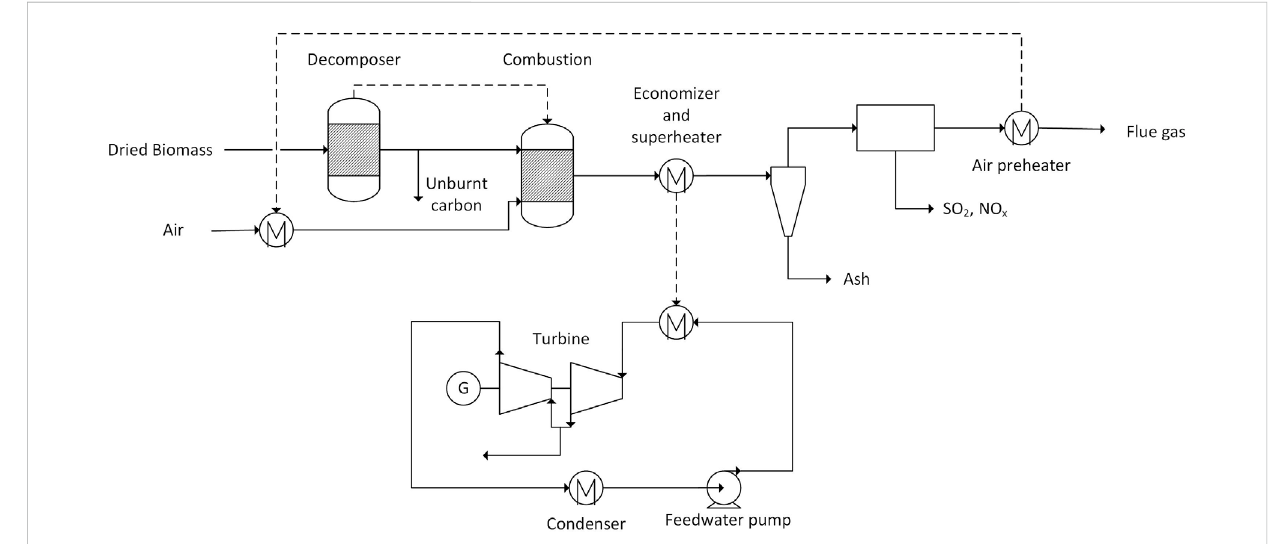
FIGURE 3 Flowsheet of the combined heat and power plant as modelled in Aspen Plus (dashed lines represent heat fl ows, solid lines are material fl